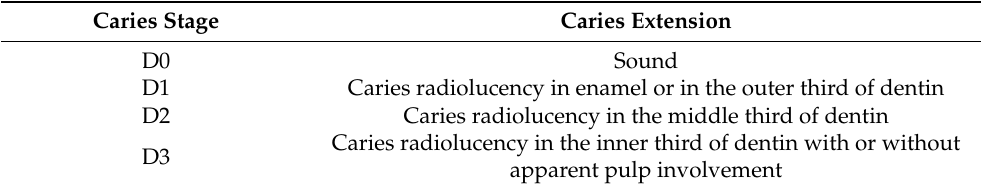
Table 1. Criterion of caries extension and their